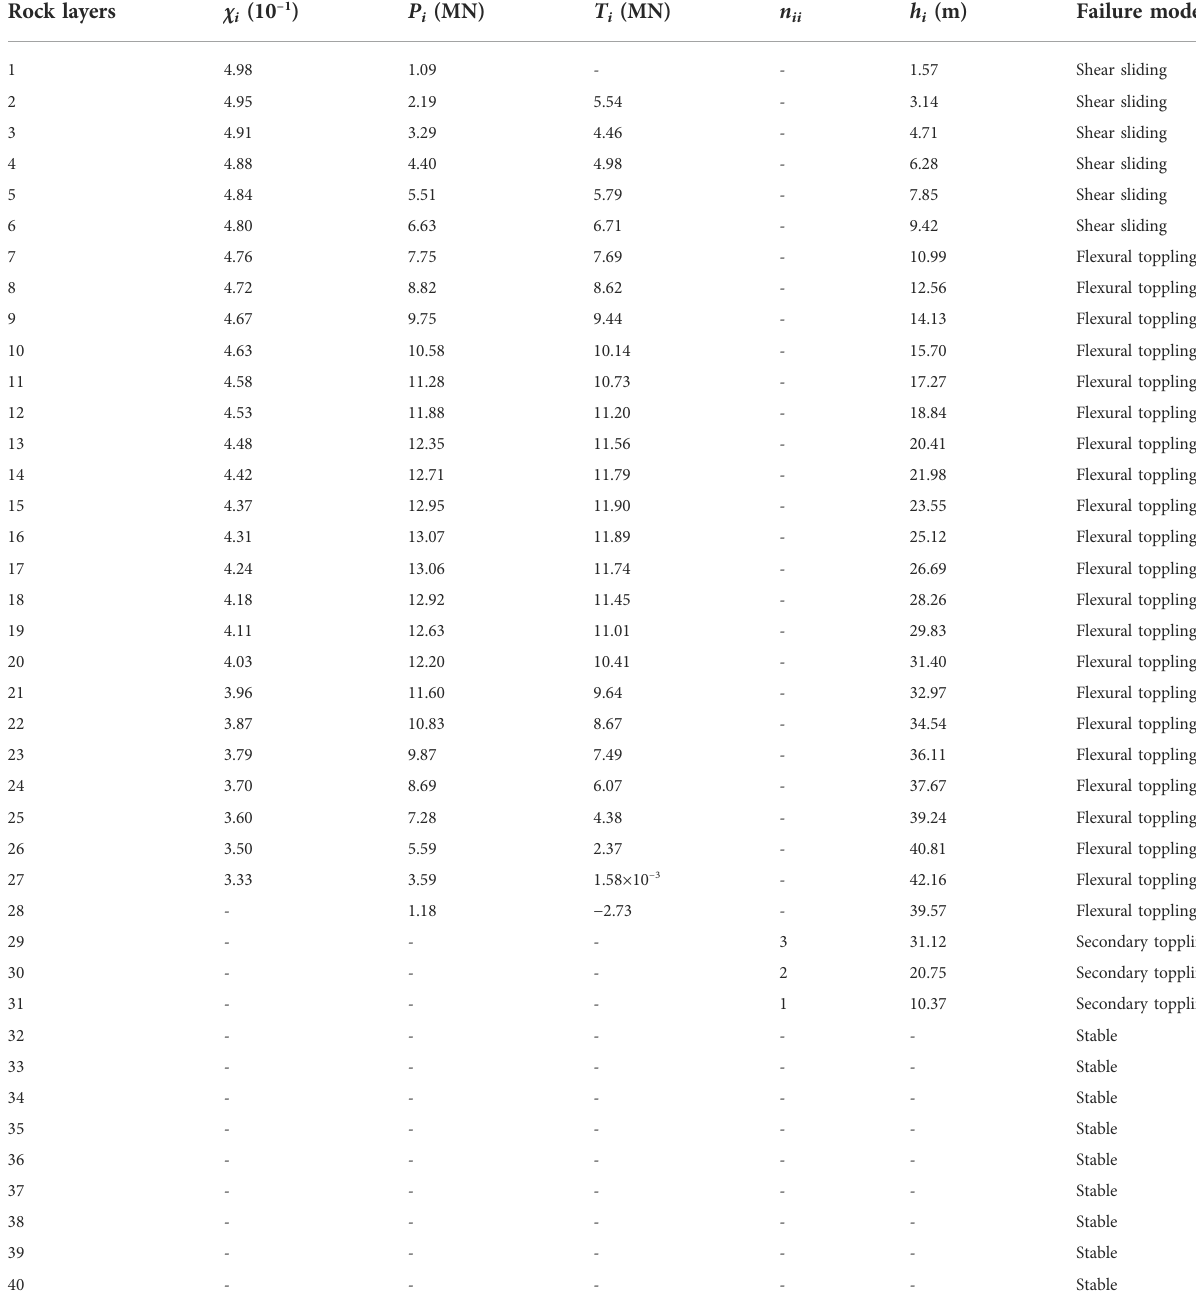
TABLE 2 Results of Yangtai slope calculated using the presented